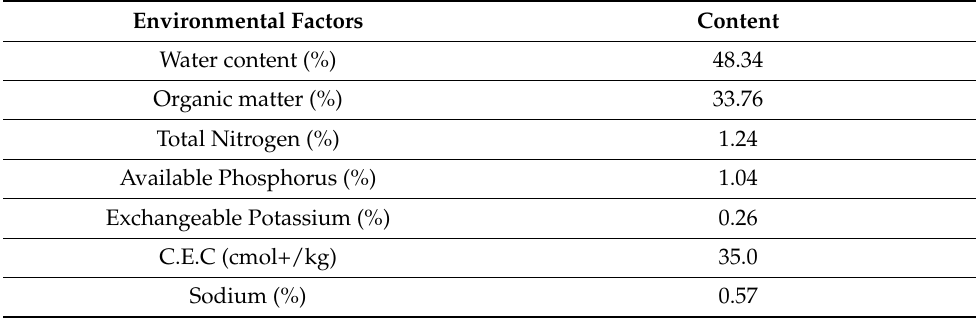
Table A1. Chemical Properties of Organic Fertilizer Planned as a Soil